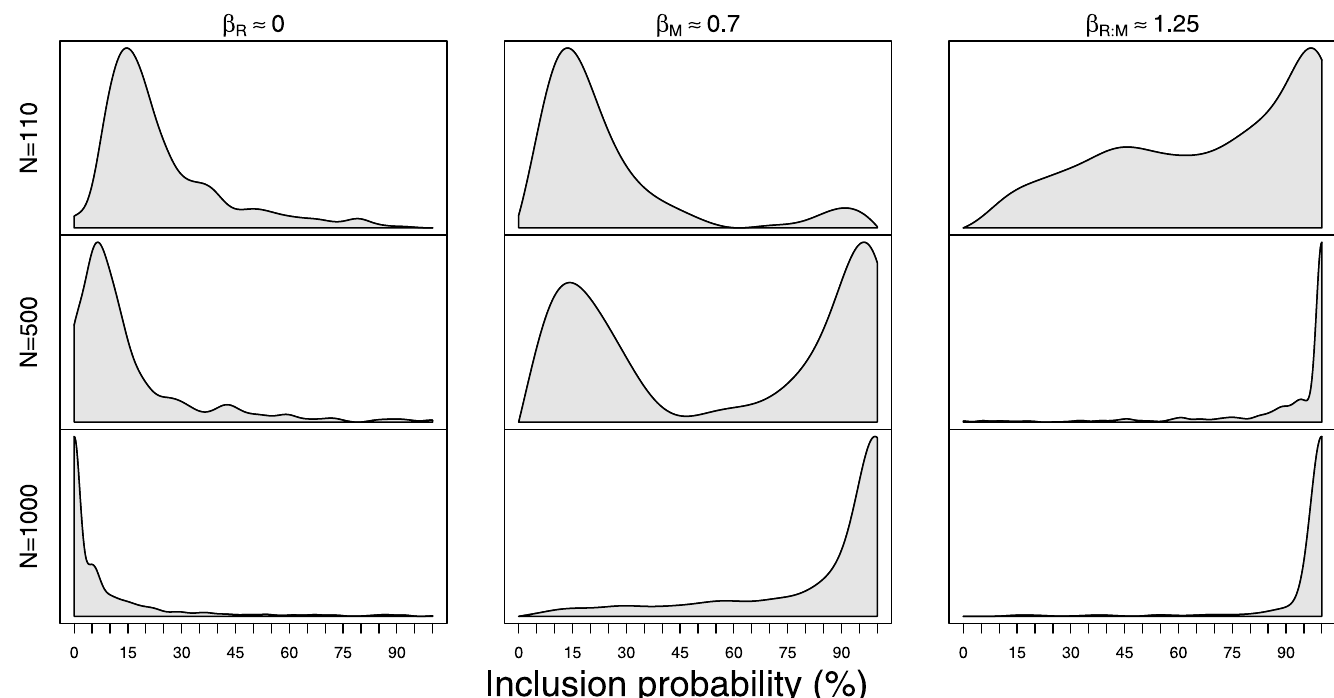
Fig 7. Distribution of estimated inclusion probabilities for each coefficient using data from the simulation study.